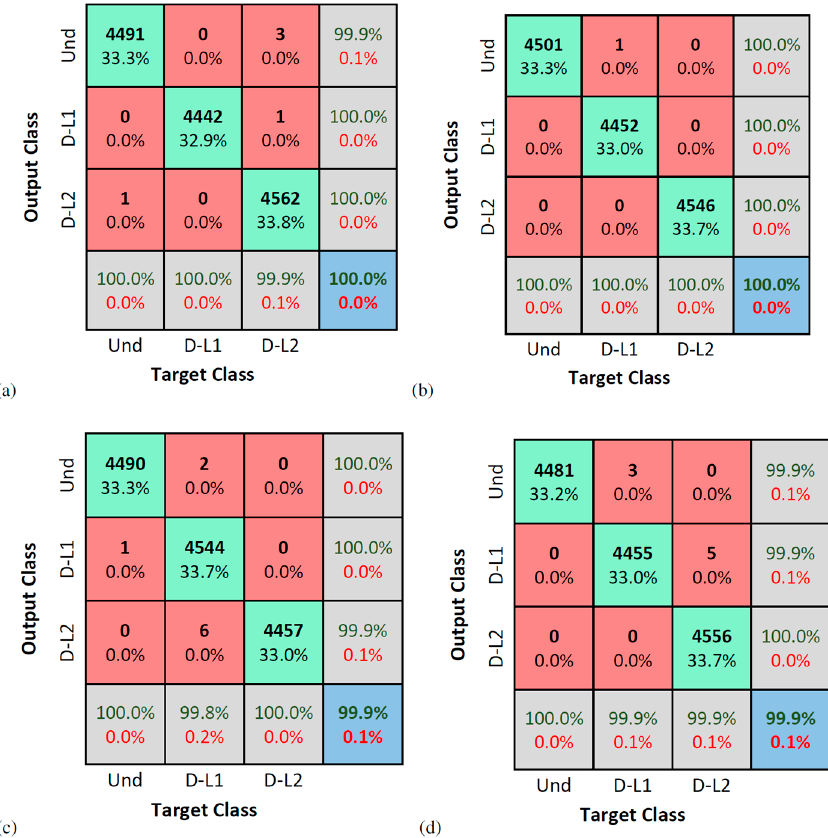
Figure 8. Simply supported numerical beam: Confusion matrices—100 SAE internal codes. ( a ) Meas- urement point Ac1. ( b ) Measurement point Ac2. ( c ) Measurement point Ac3. ( d ) Measurement point Ac4.